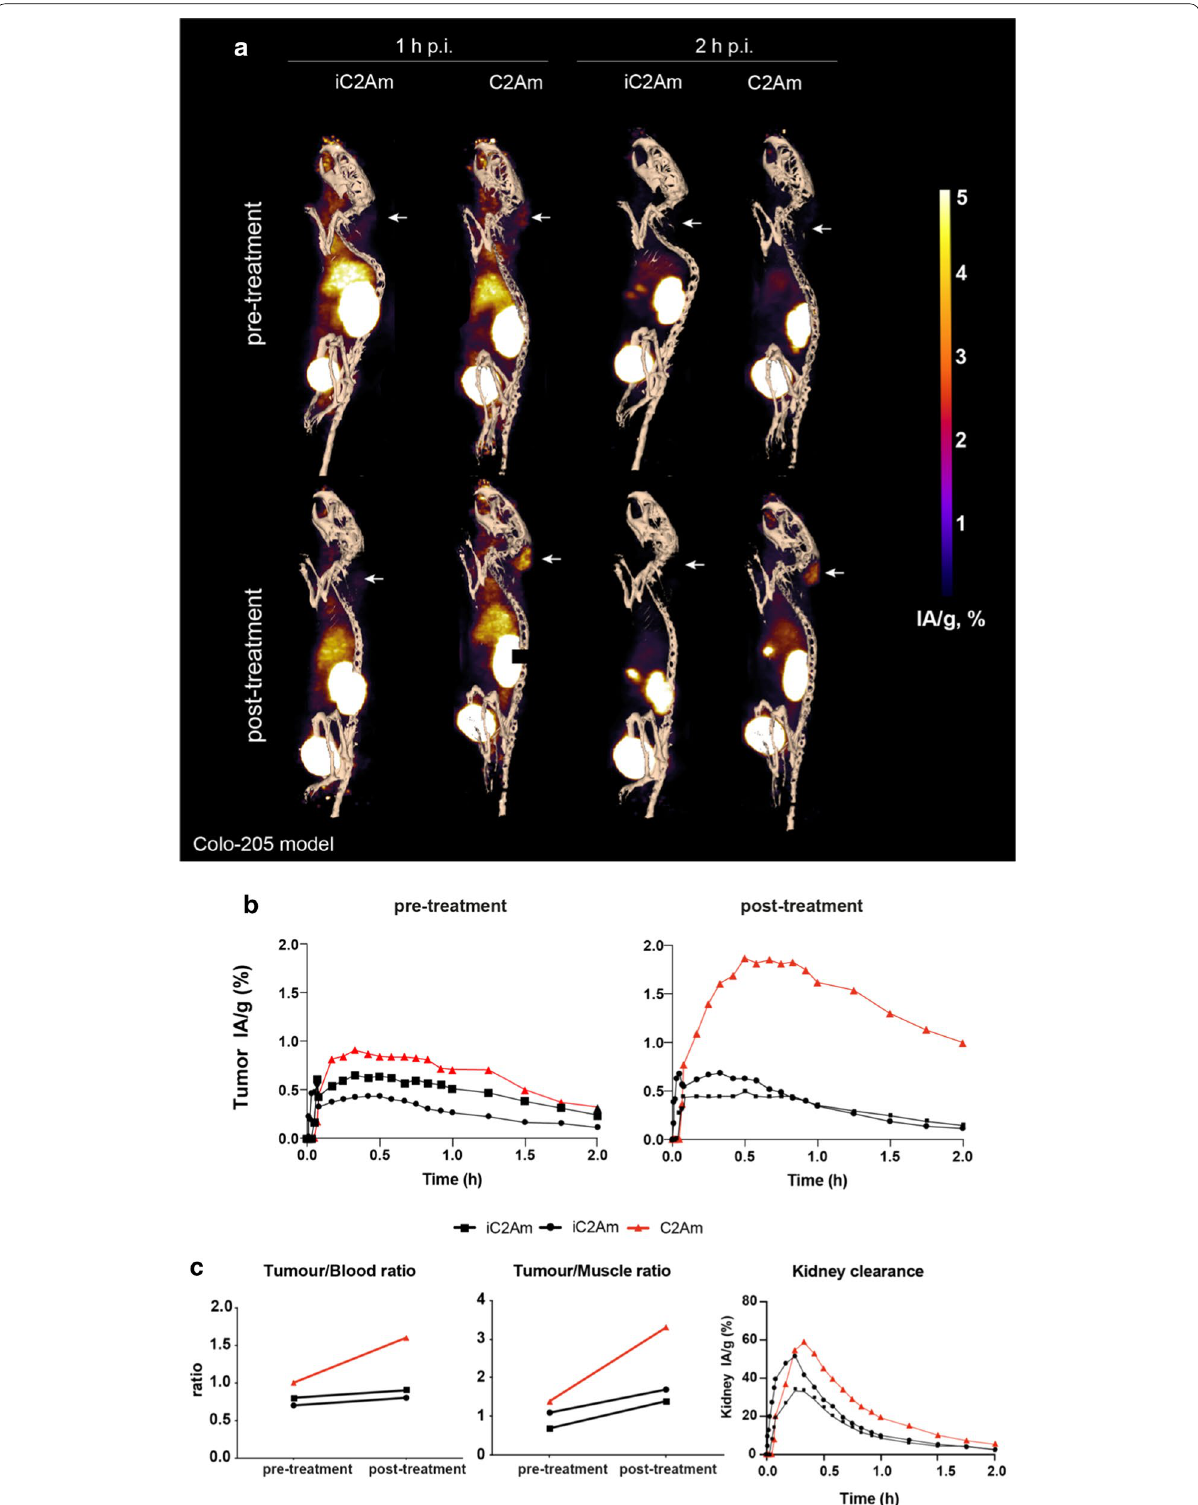
Fig. 5 Reduced tumor uptake of (inactive) 18 F‑iC2Am versus (active) 18 F‑C2Am in MEDI3039‑treated mice (0.4 mg/kg, 24 h, i.v.) bearing Colo205 tumors. Red lined triangles ( 18 F‑C2Am); black lined squares ( 18